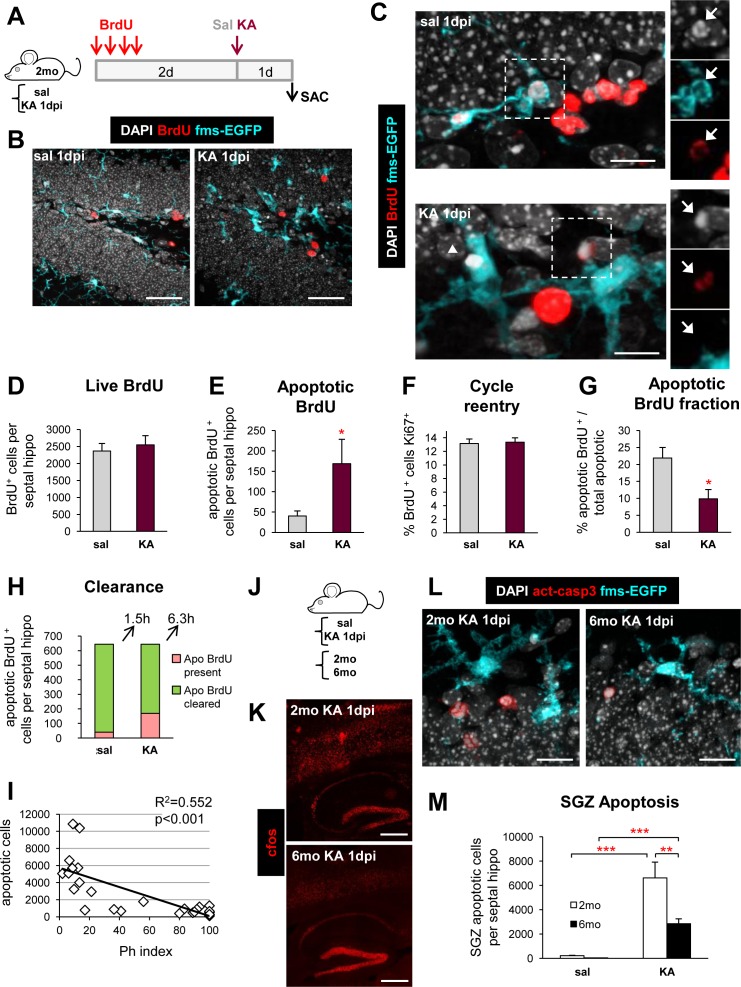
Microglial phagocytic impairment leads to delayed clearance of apoptotic cells at 1 dpi.(A) Experimental design used to analyze the survival of 3 do cells after the injection of saline (n = 7) or KA (n = 8) in mice. (B) Representative confocal z-stacks of the DG of control and KA-injected mice (1 dpi). The damage induced by KA was evidenced by the presence of cells with abnormal nuclear morphology (DAPI, white), and the altered morphology of microglia (fms-EGFP+, cyan). (C) Representative confocal images of 3 do apoptotic (pyknotic, DAPI, white) cells labeled with BrdU (red; arrows) in the SGZ of the hippocampus of saline and KA-injected mice at 1 dpi. In the saline mouse, the BrdU+ apoptotic cell, next to a cluster of BrdU+ cells, was phagocytosed by a terminal branch of a nearby microglia (fms-EGFP, cyan), whose nucleus was also positive for BrdU. In the KA mouse, the apoptotic BrdU+ cell was not phagocytosed by microglia. A nearby apoptotic cell (BrdU-; arrowhead) was partially engulfed by microglia. (D) Total number of live 3 do BrdU+ cells (nonapoptotic) in the septal hippocampus after treatment with KA. The total number of 3 do and 8 do BrdU+ cells by a single BrdU injection in saline and KA-injected mice is shown in S13A and S13B Fig. (E) Total number of apoptotic 3 do BrdU+ cells in the septal hippocampus after treatment with KA. (F) Percentage of 3 do BrdU+ cells that re-enter cell cycle, assessed by their colabeling with the proliferation marker Ki67 after treatment with KA. Representative confocal z-stacks of BrdU/Ki67 cells are found in S13C Fig. (G) Percentage of apoptotic BrdU+ cells over total apoptotic cells in the septal hippocampus. (H) Estimated clearance of apoptotic cells in the septal hippocampus. The total number of apoptotic BrdU+ (from E) present in the tissue was added to the number of estimated apoptotic BrdU+ cells that had been cleared. In saline mice, this number was calculated using the clearance time formula shown in Methods with a clearance time of 1.5 h [9]. As the total number of cells should be identical in saline and KA mice, the number of cleared apoptotic cells in KA mice was calculated as the difference between the total (in saline) and the number of present apoptotic cells (in KA). From here, we calculated a new clearance time using the same formula as in saline mice, of 6.3 h. (I) Linear regression analysis of the relationship between apoptosis and phagocytosis (Ph index) in saline and KA-injected mice (6 hpi and 1 dpi). (J) Experimental design used to compare SGZ apoptosis induced by KA at 1 dpi in young (2 mo) and mature (6 mo) mice. (K) Representative epifluorescent tiling image of the hippocampus and surrounding cortex of 2 and 6 mo mice injected with KA at 1 dpi stained with the neuronal activation marker c-fos. The same pattern of expression was found in young and mature mice throughout the DG, CA2, CA1 and the above cortex. (L) Representative confocal z-stacks of the apoptotic (pyknotic, white; act-casp3+, red) cells in the SGZ of the hippocampus of 2 mo and 6 mo mice injected with KA (1 dpi). The microglial phagocytosis impairment was similar in the two age groups (S13D Fig). (M) Total number of apoptotic cells in the SGZ of 2 and 6 mo mice treated with saline or KA (1 dpi; n = 4–5 per group). Bars show mean ± SEM. * indicates p < 0.05, ** p < 0.01, and *** p < 0.001 by Student´s t test (E, G) or by Holm-Sidak posthoc test after one-way ANOVA (M) was significant at p < 0.05. Scale bars = 50 μm (B), 20 μm (C), 500 μm (K), 25 μm (L). z = 14 μm (B), 12.6 μm (C, sal), 15.4 μm (C, KA), 25 μm (L). Underlying data is shown in S1 Data.